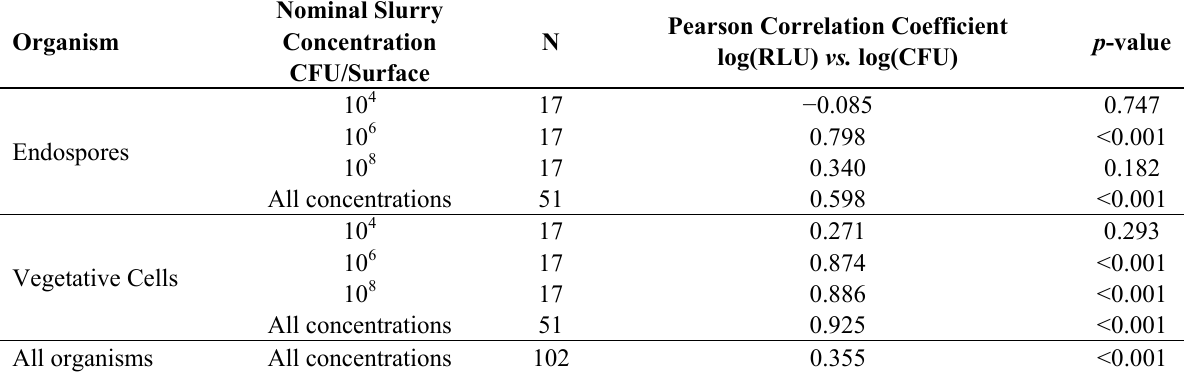
Table 3. Correlations between log(RLU) and log(CFU) for B. anthracis Sterne